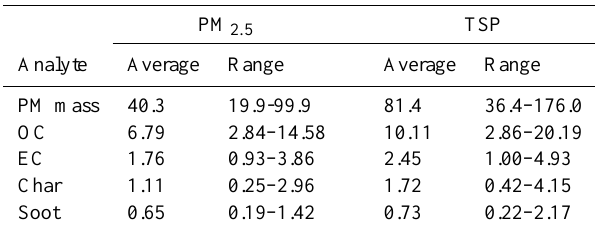
Table 2. Concentrations of PM mass, OC, EC, char, soot in PM 2 . 5 and TSP (units: µgm − 3